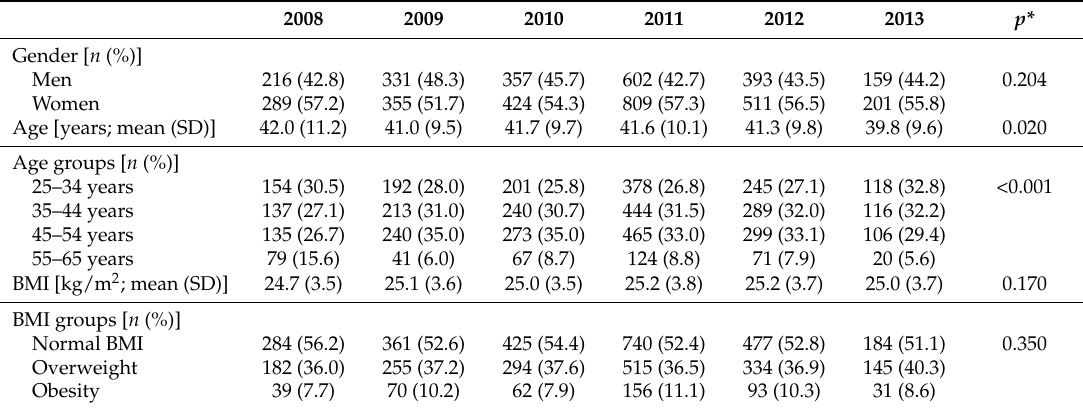
Table 1. Characteristics of the study samples in the survey periods